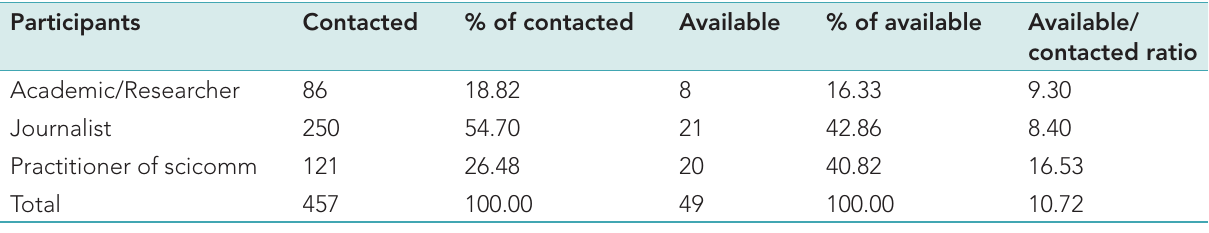
Table 2. Composition of participants in the Delphi panel (Source: Authors, 2022)